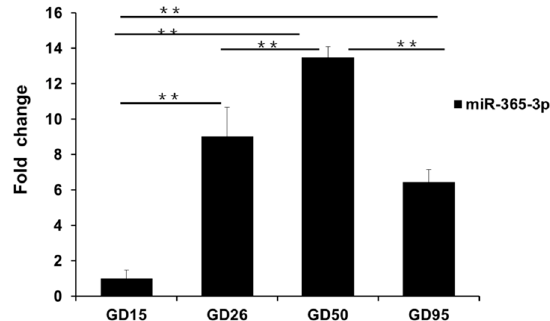
Figure 8. Investigation of the expression pattern of miR-365-3p in pig conceptus (Day 15 of gestation) and placenta by using qRT-PCR. Data are shown as mean ± SEM of three independent experiments. ** p < 0.01. GD: gestational day.